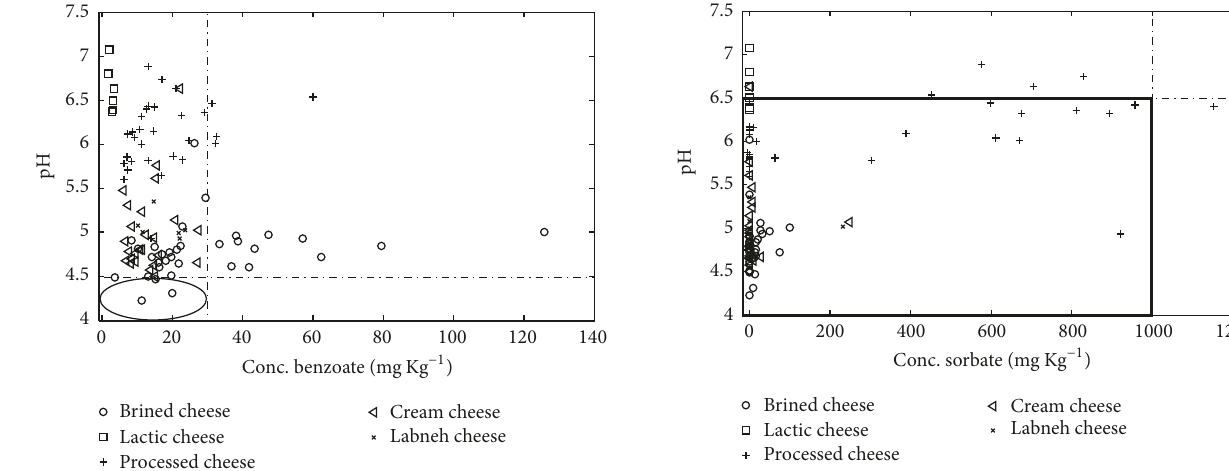
Figure 4: Illustration of benzoate content and the pH in each cheese sample. The samples that located in the violet ellipse have the standard concentration and pH level.